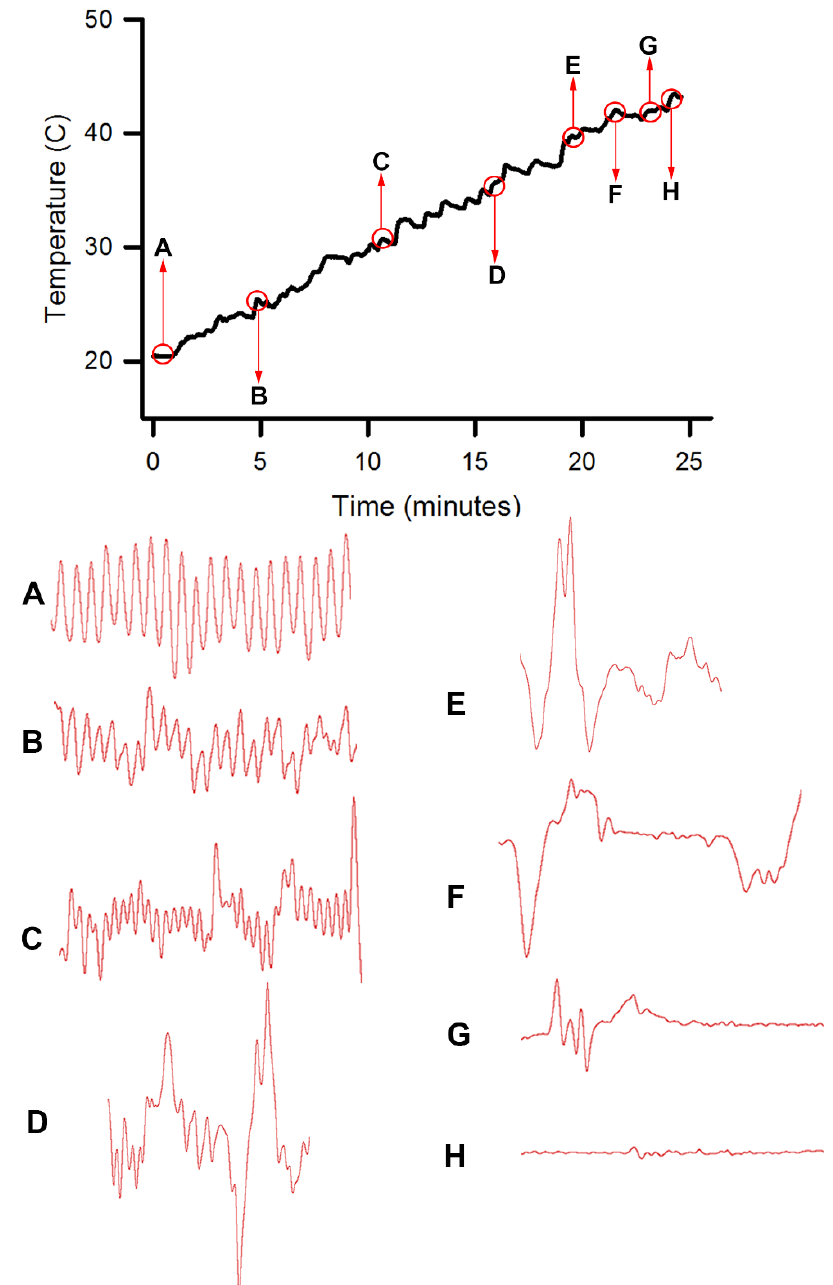
Figure 5. Heart rate measures at various water temperatures starting at 21 °C and increasing at ~1 °C per minute. The ECG traces are shown at the various time points while the temperature was increasing. The letters in the top trace correspond to the traces shown below in alphabetical order. Each trace is 10 s in duration.